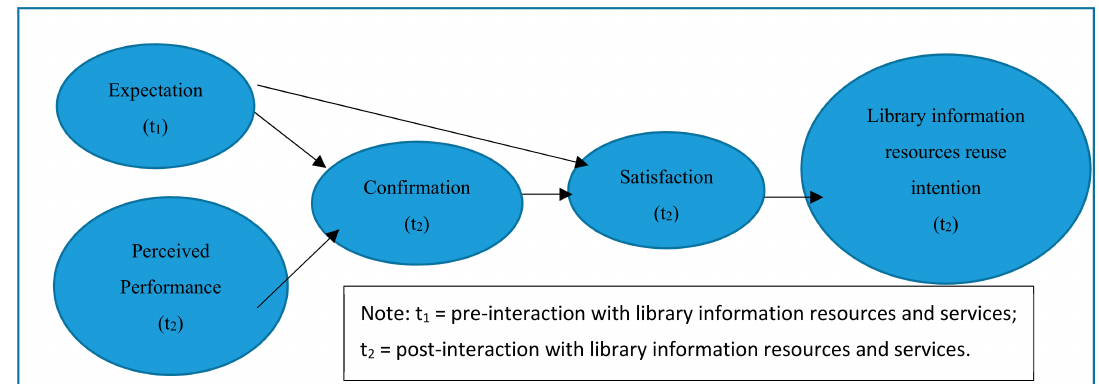
Figure 1. The conceptual framework of expectation confirmation theory for library information resource use (Source: Conceptual framework based on literature